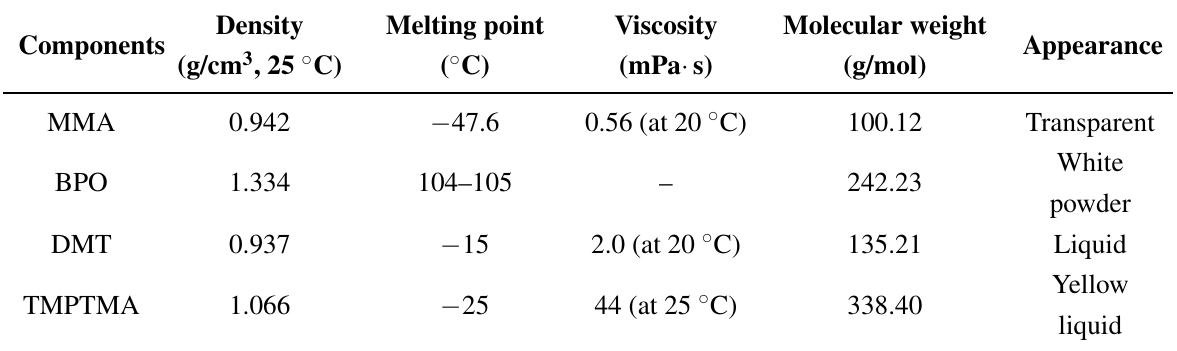
Table 1. Physical properties of various binder